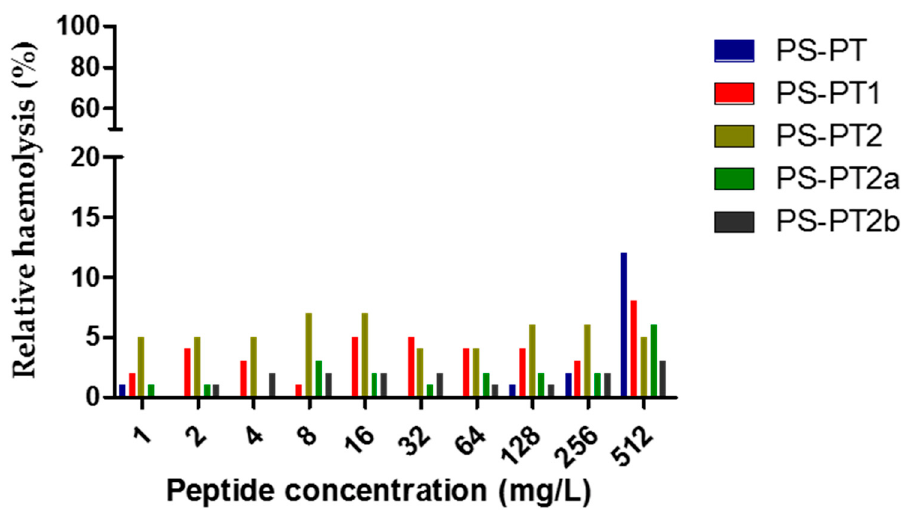
Figure 6. Relative haemolysis of PS-PT and its analogues. The 100% haemolysis was induced by 1% Triton X-100.